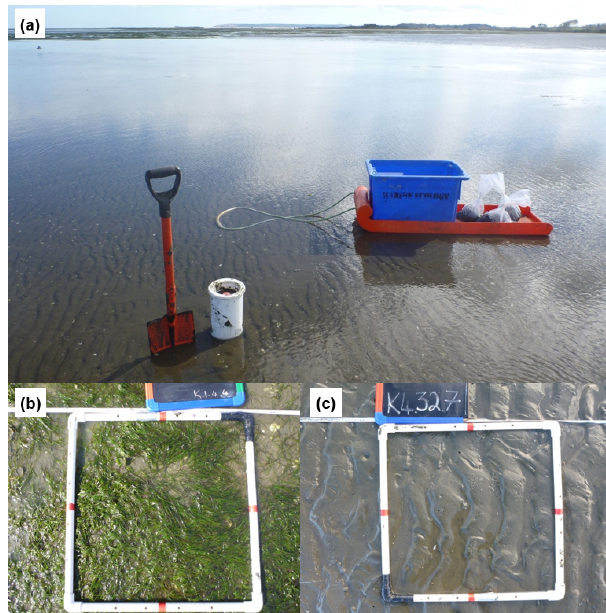
Figure 1. (a) Example of a sampling area during low tide and the low-tech gear used for sampling. Examples of (b) a high-density seagrass sampling point and (c) a sandy sampling point (photos: Casper